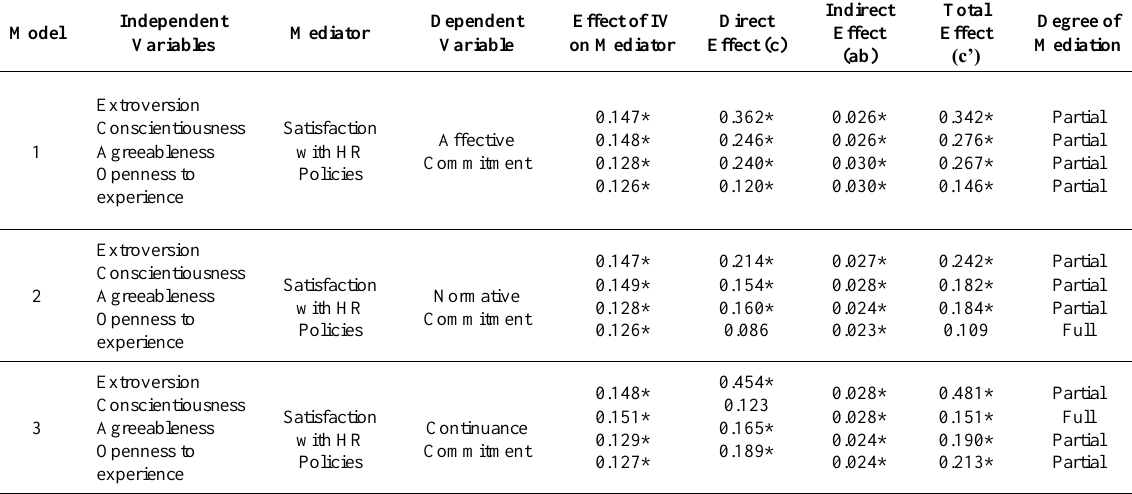
Table.4: Results of Structural